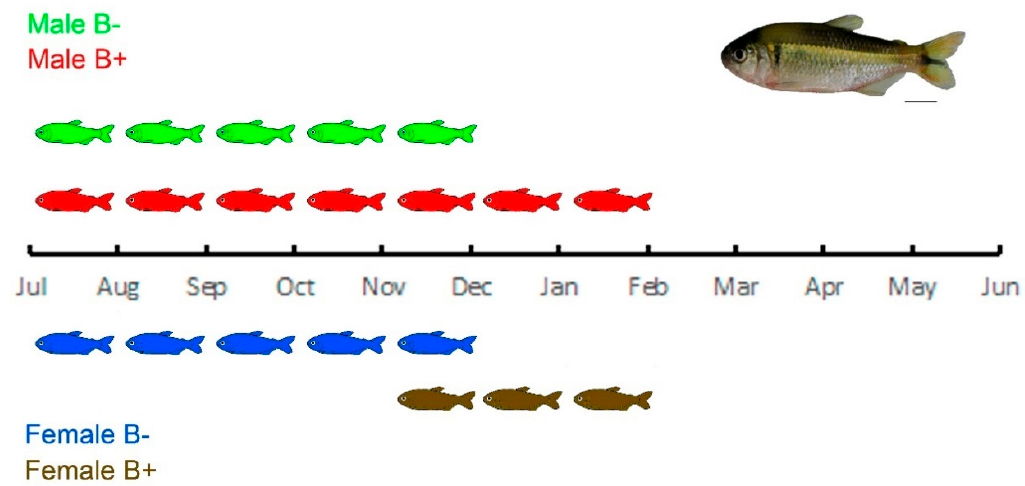
Figure 4. Representation and data of the reproductive period of A. scabripinnis, according to [31,35]. B − : without B chromosome, B + : with B chromosome. It is important to highlight the late reproductive activity of females with B chromosomes and the extension of males carrying the additional chromosome, which allows them to reproduce with females with or without B chromosomes throughout the period, ensuring the maintenance of this chromosome in the population. Fish bar: 1 cm. Table S1: Statistical analysis ( p < 0.05) for amh and foxl2a